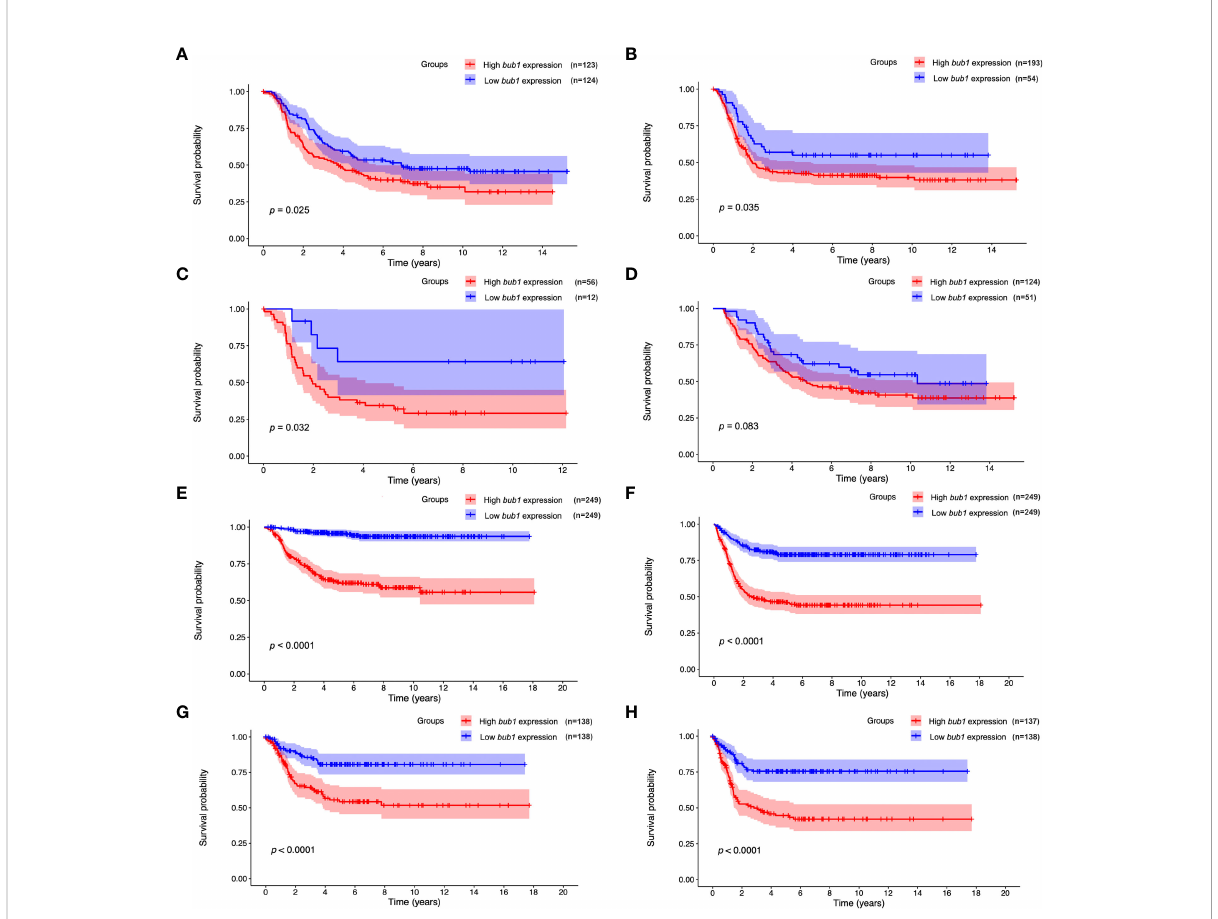
FIGURE 1 Prognostic value of bub1 in neuroblastoma. (A, B) Kaplan – Meier curve using the TARGET dataset showed lower overall survival (A) and recurrence-free survival (B) in patients with highly expressed bub1 relative to that with low bub1 expression. (C, D) Kaplan-Meier curve using the TARGET dataset showed lower overall survival in high- bub1 -expression patients with (C) or without (D) MYCN ampli fi cation in comparison with their low- bub1 -expression counterparts. (E, F) Kaplan-Meier curve using the GSE62564 dataset showed lower overall survival (E) and recurrence-free survival (F) in patients with highly expressed bub1 relative to that with low bub1 expression. (G, H) Kaplan – Meier curve using the GSE85047 dataset showed lower overall survival (G) and recurrence-free survival (H) in patients with highly expressed bub1 relative to that with low bub1 expression.